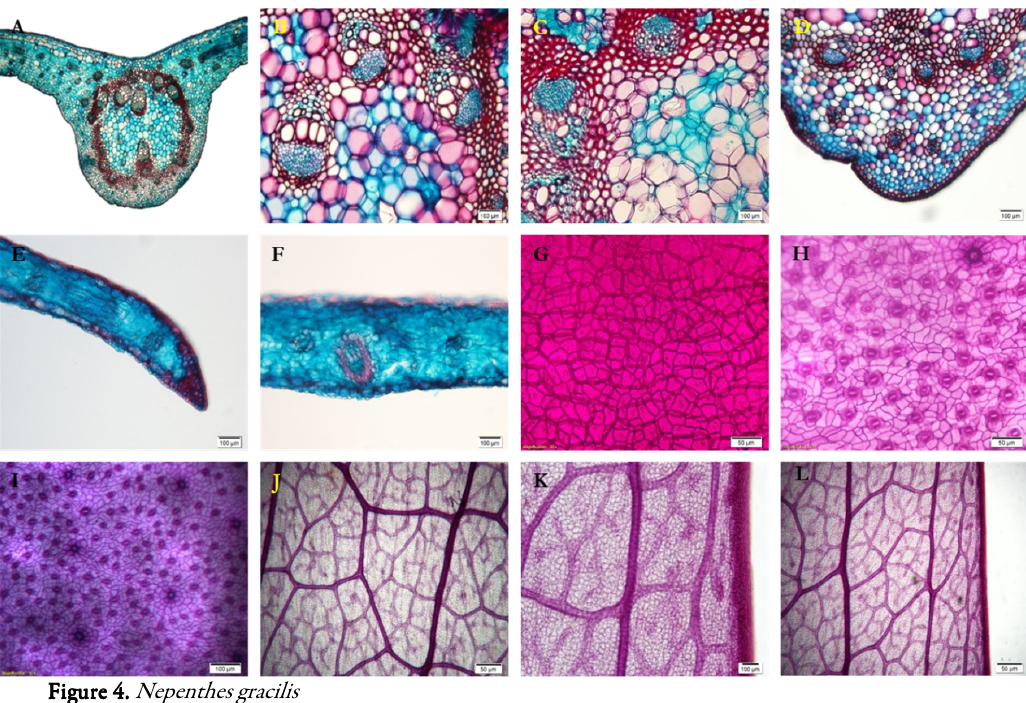
Figure 4. Nepenthes gracilis (A) Midrib TS. (B) Observation of solitary crystals. (C) Close up of vascular bundle. (D) Midrib abaxial part. (E) Margin TS. (F) Lamina TS. (G) Adaxial epidermis. (H) Abaxial surface. (I) Sessile gland. (J) Lamina venation. (K) Areolar venation. (L) Margin venation. Bars A, G, H, J, L: 50µm; B, C, D, E, F, I, K: 100µm.